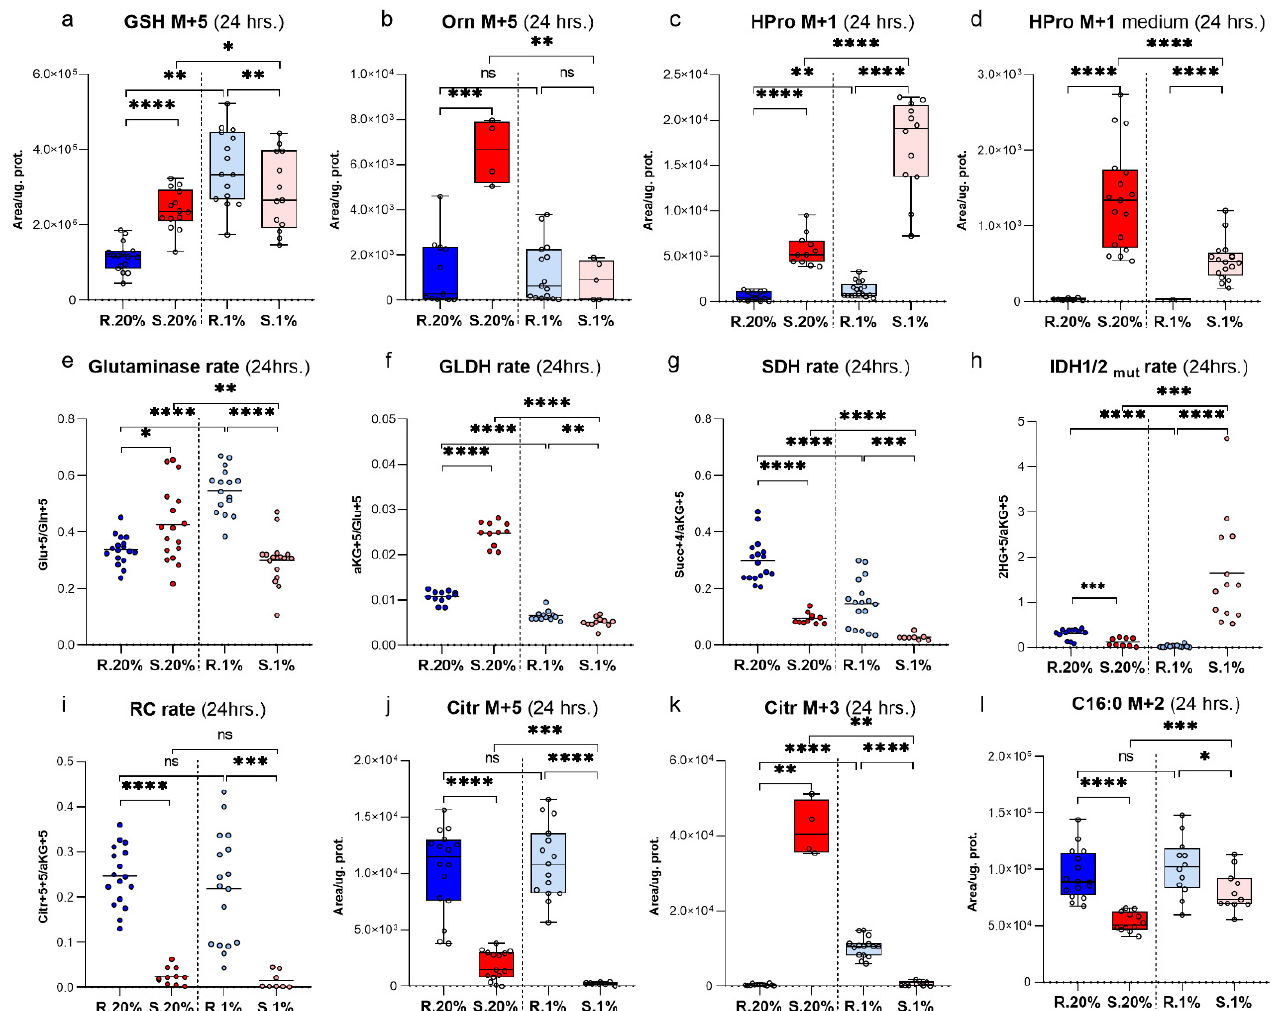
Figure 2. Tracking the fate of Gln+5 after non-TCA cycle transformations: intracellular levels of ( a ) GSH+5; ( b ) Orn+5; The reductive carboxylation of Gln+5; intracellular levels of ( c ) HPro+1; ( j ) citrate+5; ( l ) C16:0+2; ( d ) extracellular levels of HPro+1; the Malic Enzyme-metabolized Gln+5: intracellular levels of ( k ) citrate+3. The calculated rates for ( e – i ) glutaminase, glutamate dehydrogenase, succinate dehydrogenase, and isocitrate dehydrogenase in Spalax and rat cells that were cultivated for one day under normoxia and hypoxia. S.20%, R. 20%, S.1%, R1% represent the Spalax (S) and rat (R) cells that were exposed to an atmosphere containing 20% or 1% O 2 , respectively; ns, (nonsignificant) p > 0.05; * p < 0.05; ** p < 0.01; *** p < 0.001; **** p < 0.0001, the error bars represent standard deviation of 6 or more biological repeats. Each point on the chart represents one technical repeat.